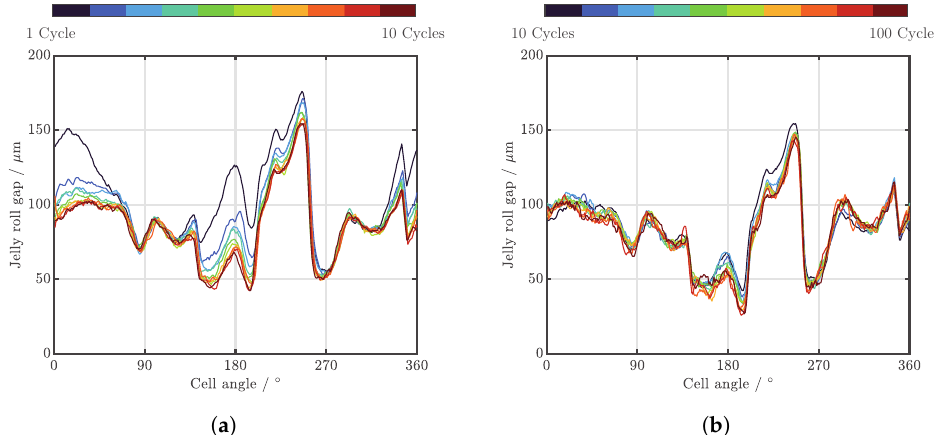
Figure 9. Jelly-roll gaps for the Samsung INR21700-40T at 100% SOC with smoothed data. ( a ) Jelly-roll gap each cycle for the first 10 cycles. ( b ) Jelly-roll gap each 10 cycles for the first 100